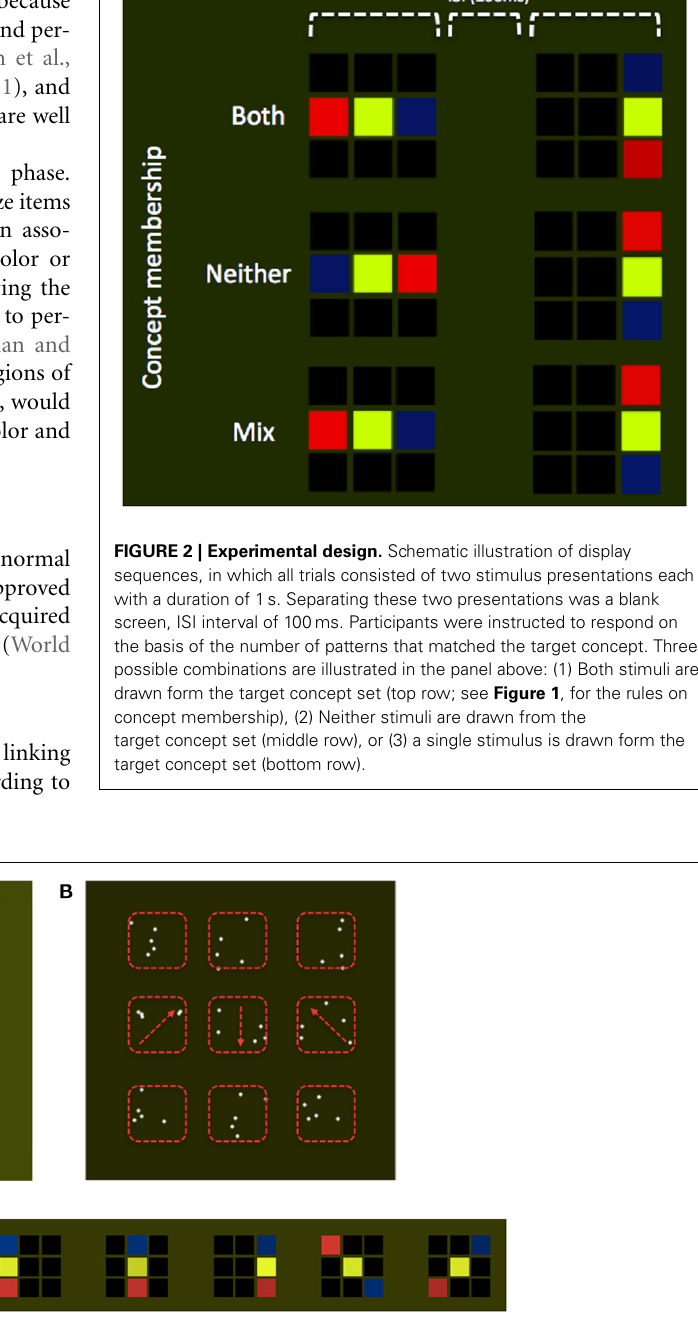
Red dashed rectangles (not shown to observers) mark the boundaries of the areas in which dots could be displayed. The concept consisted of sequences of moving dots, with directions 45 ◦ , 180 ◦ , or 315 ◦ . Panel (C) displays all patterns belonging to the target color concept, including the example displayed in Panel (A) (far right). For all of the patterns displayed the relational properties between elements remain constant, regardless of the spatial position of the colored squares, i.e., Red precedes yellow precedes blue, from left to right, or from bottom to top. Diagonal patterns follow the left to right rule. This constant relationship between the colors or the directions of motion constitutes the invariant feature defining the target